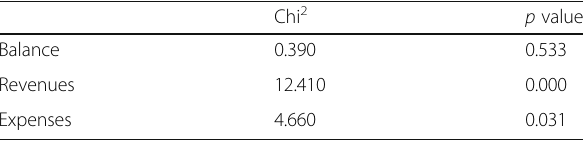
Table 10 Breusch and Pagan Lagrangian multiplier test for